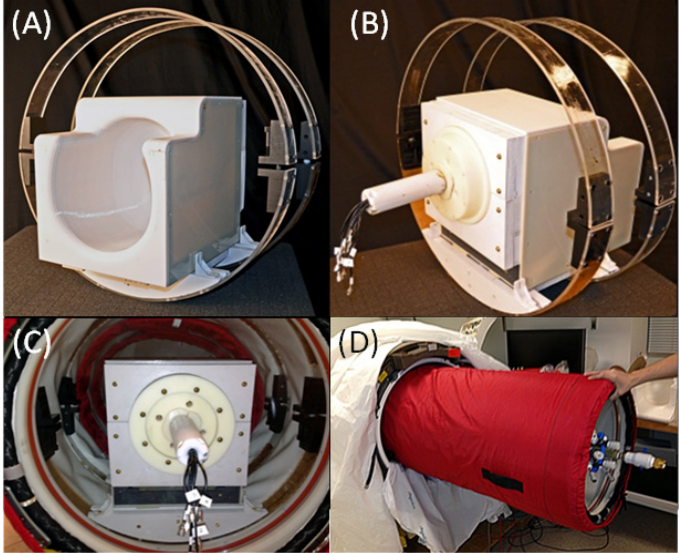
Figure 4. Images of the HBO2-compatible MRI coil with special mechanical modification with re- spect to the standard commercial MRI coil to allow it to fit into the Hyperlite window ( A , B ), during pressurization testing ( C ), and while being inserted in a Siemens body RF coil ( D ).